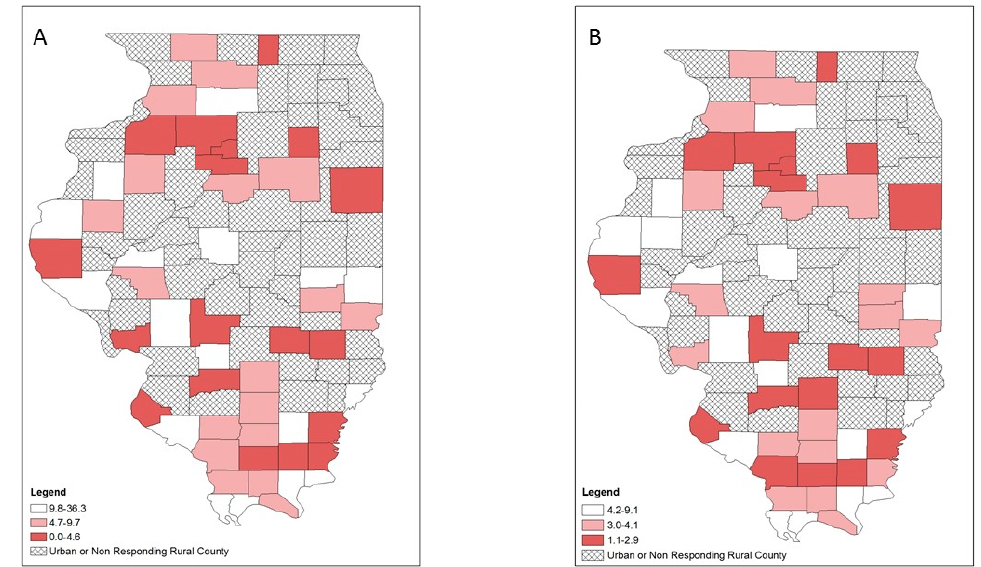
Figure 2. Opioid-use disorder (OUD) treatment services at local health department services per 100,000 population by tertiles, respondent rural counties, Illinois, 2018: ( A ) crude rates; ( B ) empirical Bayes estimated rates.